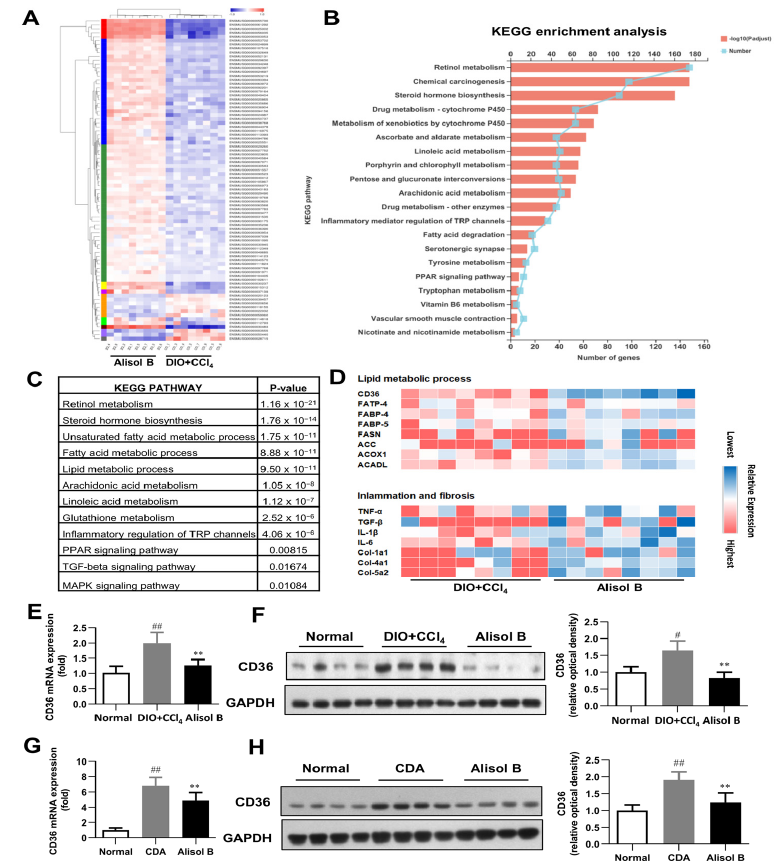
Figure 3. RNA-seq analysis. ( A ) Heat map, ( B ) KEGG enrichment analysis, ( C ) enriched KEGG biological pathway, and ( D ) kay genes expression involved in lipid metabolic process, inflammation, and fibrosis were performed in the liver of DIO+CCl 4 -induced mice. ( E ) RT-PCR analysis and ( F ) Western blot analysis of CD36 expression were conducted in DIO+CCl 4 -induced mice. ( G ) RT-PCR analysis and ( H ) Western blot analysis of CD36 expression were conducted in CDA-diet-fed mice. Data are expressed as mean ± SD, n = 8. # p < 0.05, ## p < 0.01 compared with the normal control group; ** p < 0.01 compared with the DIO+CCl 4 group or CDA group.